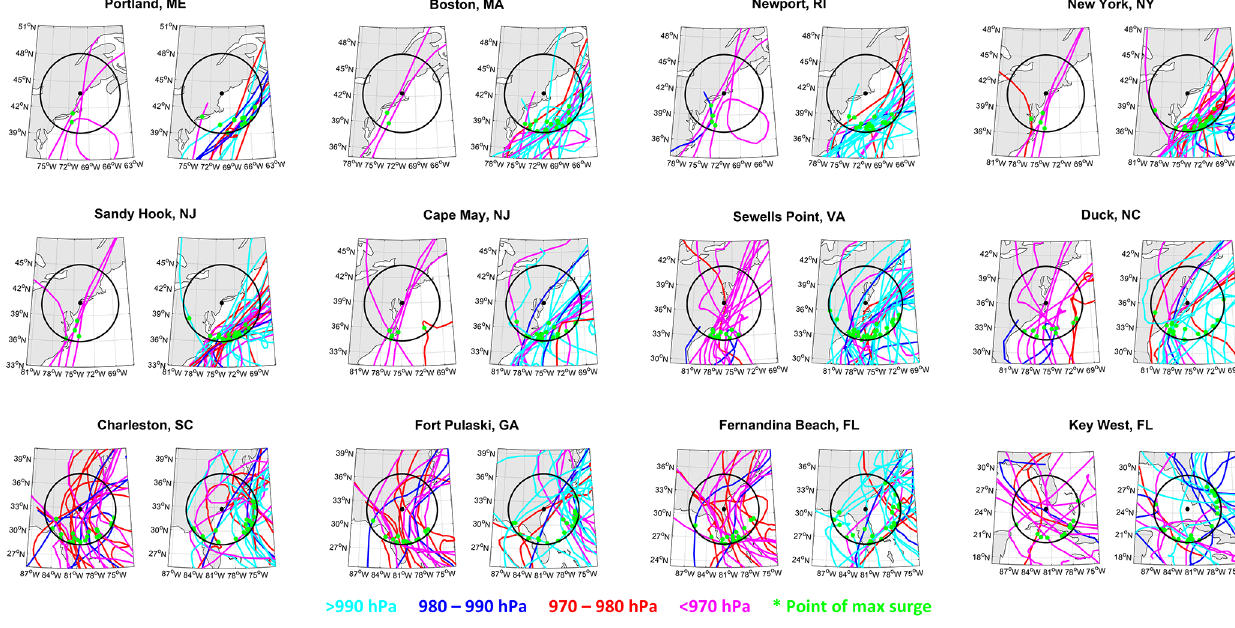
Figure 7. For each location, strong TC tracks for those TCs that do result in surge exceeding 1-year return level (left) and those that do not (right). Tracks are color coded based on average MSLP as follows: > 990hPa (light blue), 980–990hPa (dark blue), 970–980hPa (red), and < 970hPa (magenta). The black circle represents 500km radius. Green dots represent the closest TC location at the time of surge